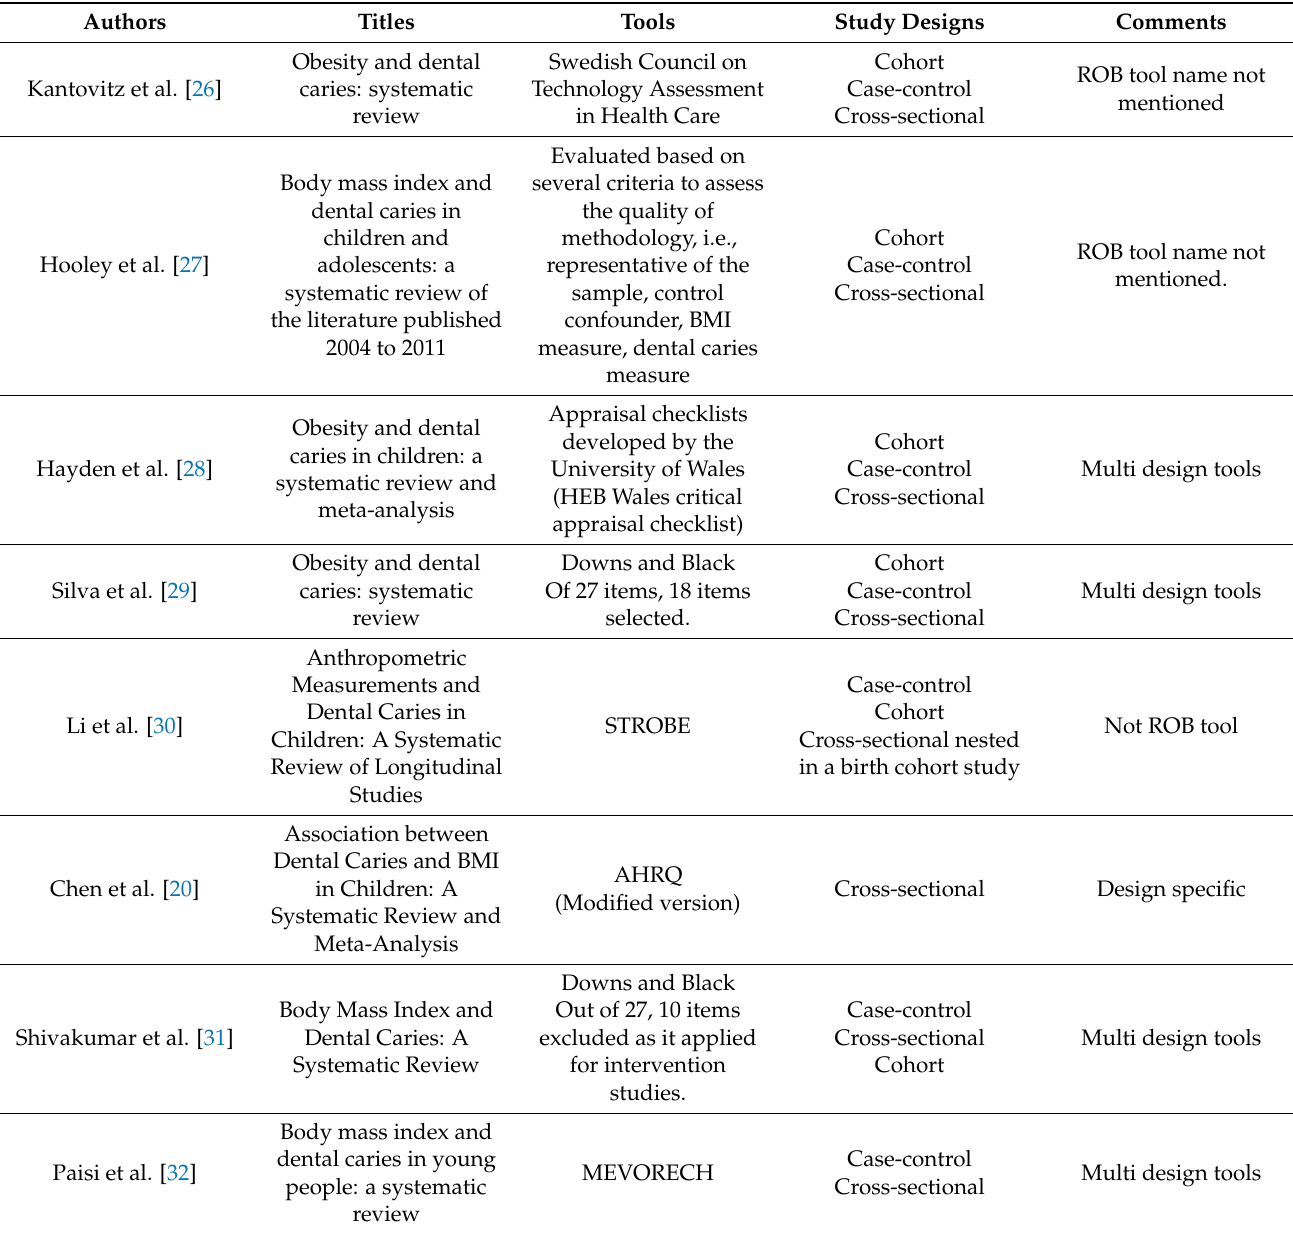
Table 1. List of eleven ROB tools used in previous systematic